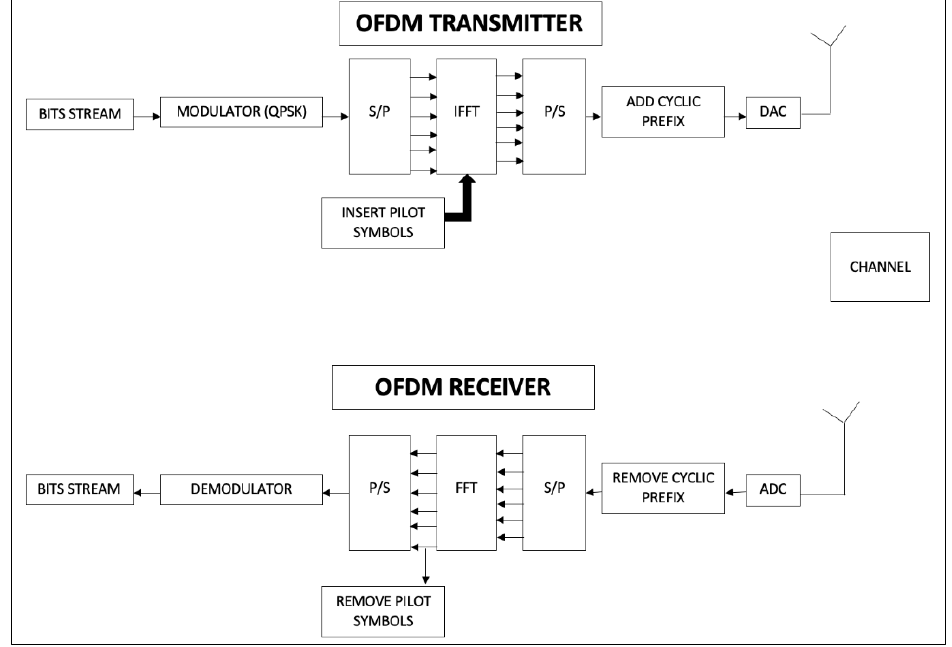
Figure 1. Complete transceiver model of an OFDM